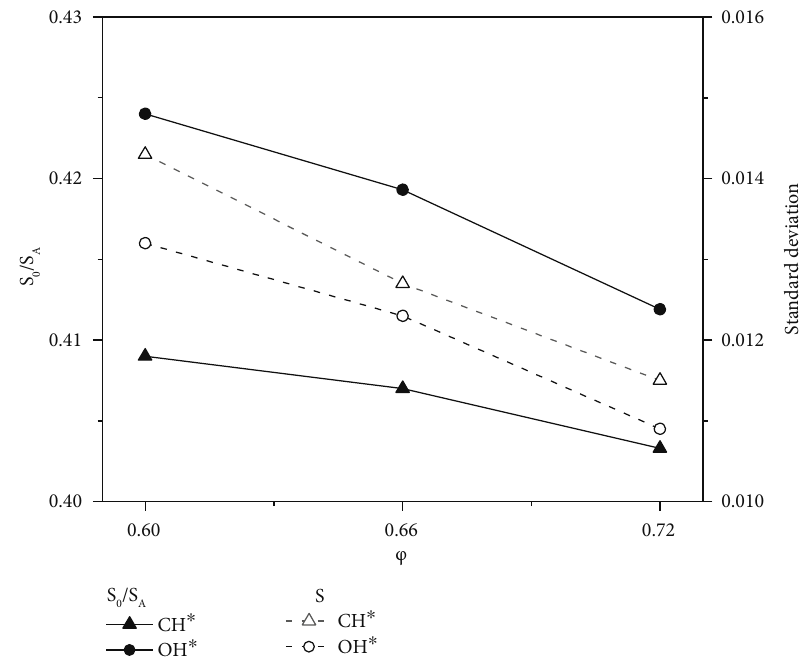
Figure 11: Area and standard deviation of the reaction zone and the heat release zone.